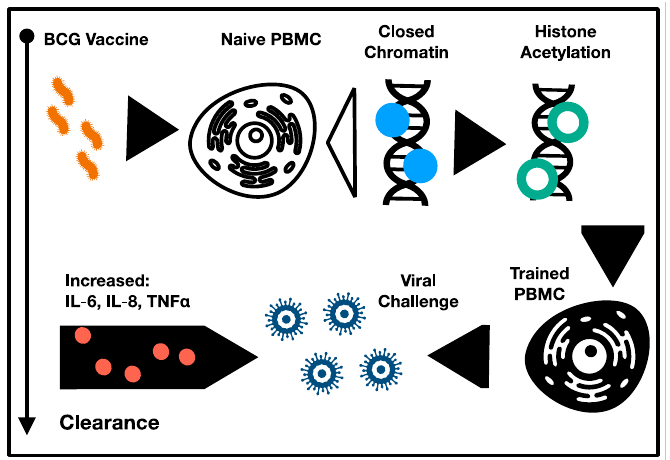
Figure 2. Epigenetic remodeling following non-specific vaccination aggregates in increased production of pro-inflammatory cytokines during viral challenge. Figure was made using keynote. [25,39–41].